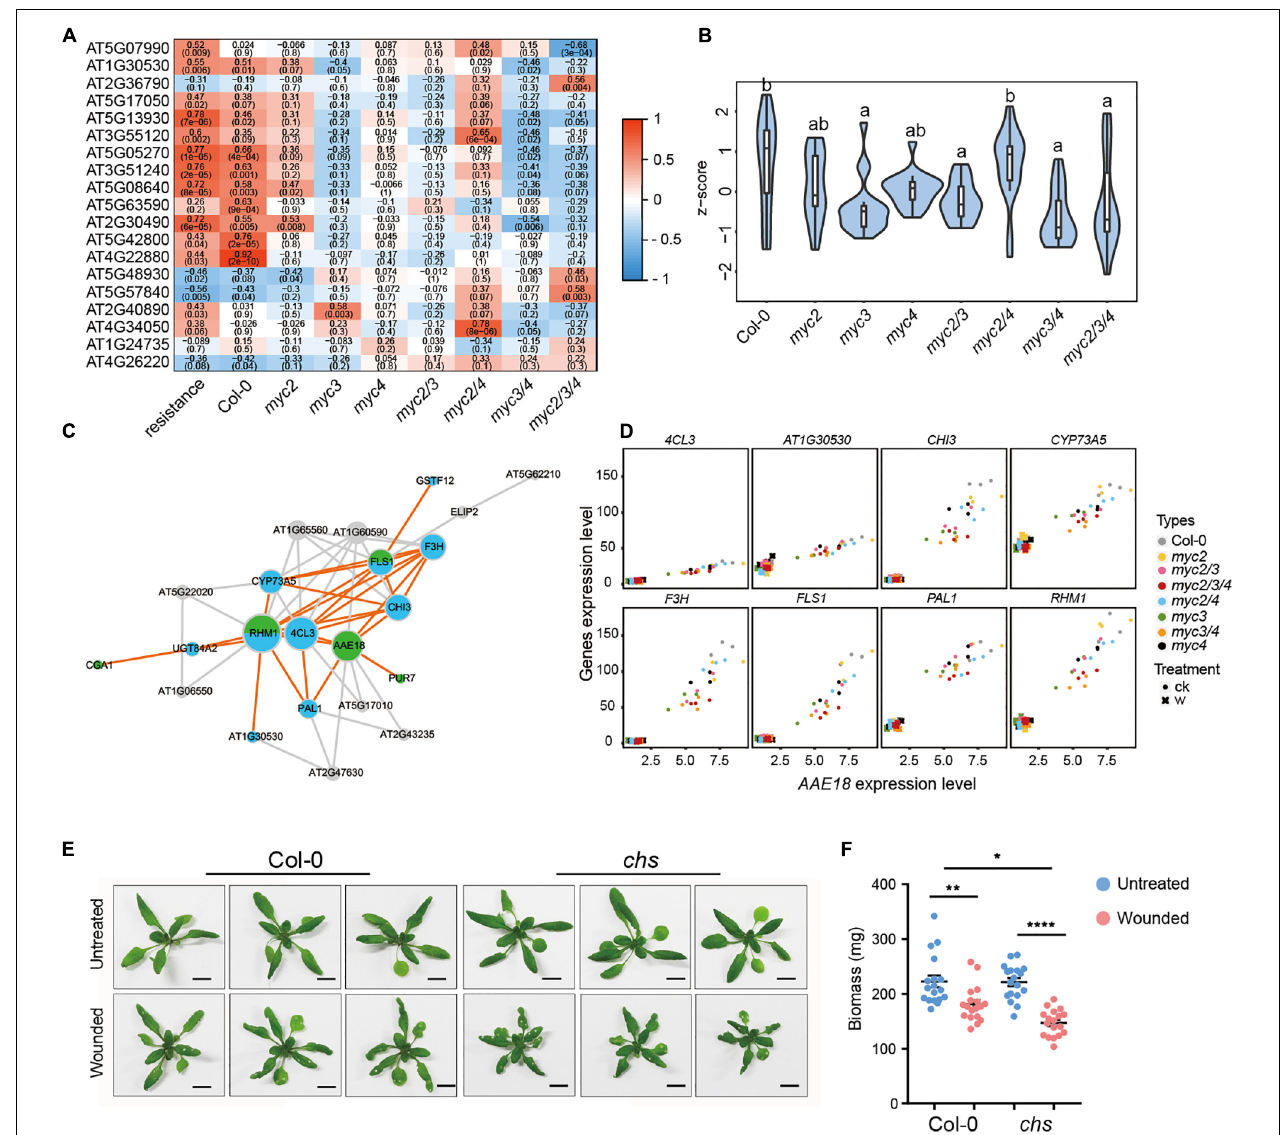
FIGURE 5 | Flavonoids alleviate the growth inhibition caused by intermittent wounding. (A) Heatmap showing the effect of MYCs on the expressions of flavonoid synthesis genes positively associated with plant resistance. Red to blue represents the positive to negative correlation between gene expression and resistance. The number indicates correlation coefficient, and the number in brackets indicates P -value. (B) The violin plot of flavonoid gene expression in myc -related mutants in untreated plants. Z -score represent the normalized TPM of each gene. The detailed flavonoid gene information is presented in Supplementary Table 14 . Data are analyzed by one-way ANOVA and Tukey’s HSD test. Different letters indicate significant differences, P -value < 0.05. (C) Co-expression network of flavonoid synthesis and growth-related genes. Blue and green stand for flavonoids synthesis genes and growth-related genes, respectively. (D) Scatter plot displays the co-expression of AAE18 with the eight flavonoid synthesis genes. X -axis stands for the AAE18 expressions (TPM), and Y -axis stands for the expressions (TPM) of the indicated genes in flavonoids synthesis. Dots represent the gene expressions in untreated samples, and crosses represent the gene expressions in wounding treated samples. (E,F) Images (E) and Biomass (F) of WT and CHS with intermittent wounding treatments. When plant has grown for 12 days, the first wounding treatment is performed, and the wounding treatment is performed every 3 days for a total of three times. (E) Scale bar, 1 cm. (F) Data are means ± SEM ( n = 18) and analyzed by two-way ANOVA and Tukey’s HSD test. * P < 0.05, ** P < 0.01, **** P <